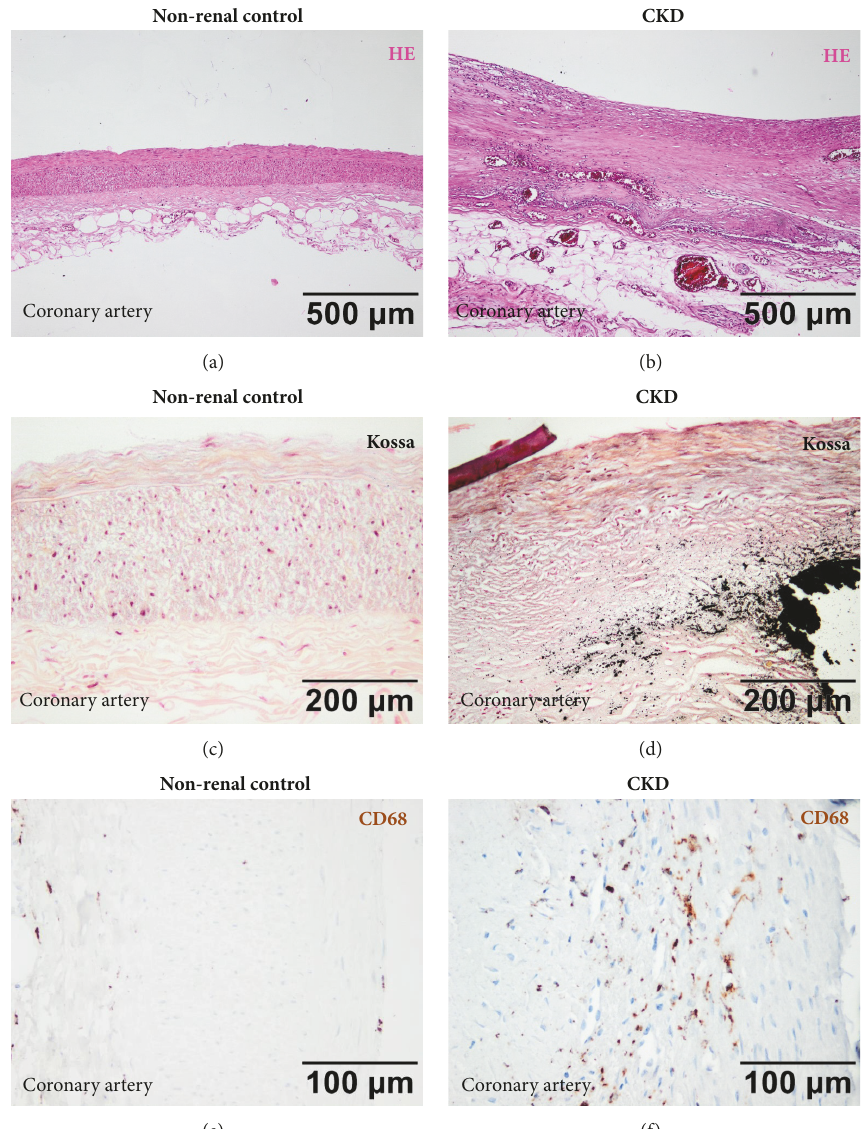
Figure 1: (a-f) Rep r esentative vascula r findings in non r enal cont r ol patients (a, c, e) and patients with ch r onic kidney disease (CK D ). (a, b) Marked thickening of coronary arteries in CKD patients (b) compared to nonrenal controls (a). HE-stain. (c, d) Marked calcification of the arterial intima and media and atherosclerotic coronary plaques in CKD patients (d) compared to nonrenal controls (d). Von Kossa stain. (e, f) Increased number of CD68 positive macrophages in the vascular wall of CKD patients (f) compared to nonrenal controls (e).